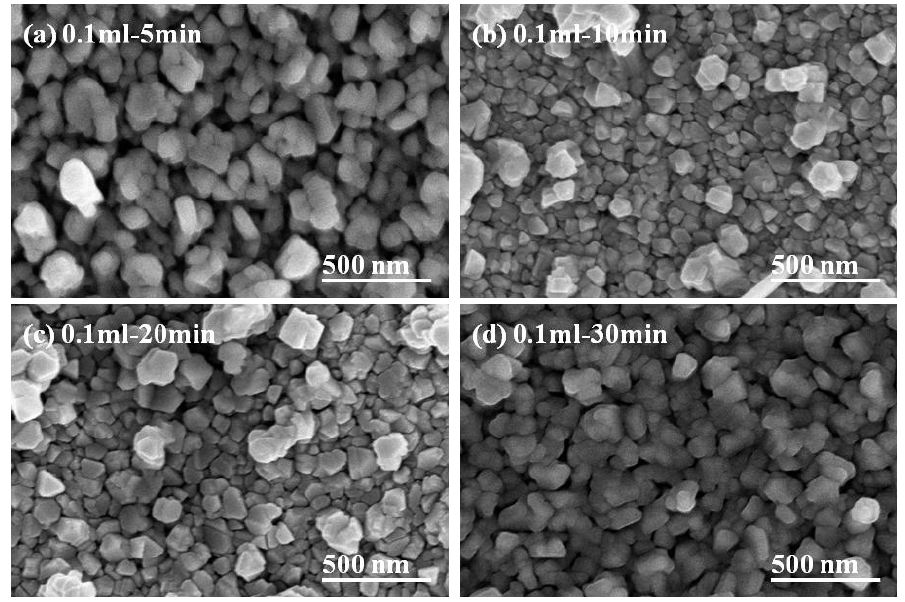
Figure 6. Surface morphologies of the CIS absorber layers as a function of annealing time, the using solution volume was 0.1 mL. ( a ) 5 min; ( b ) 10 min; ( c ) 20 min; ( d ) 30